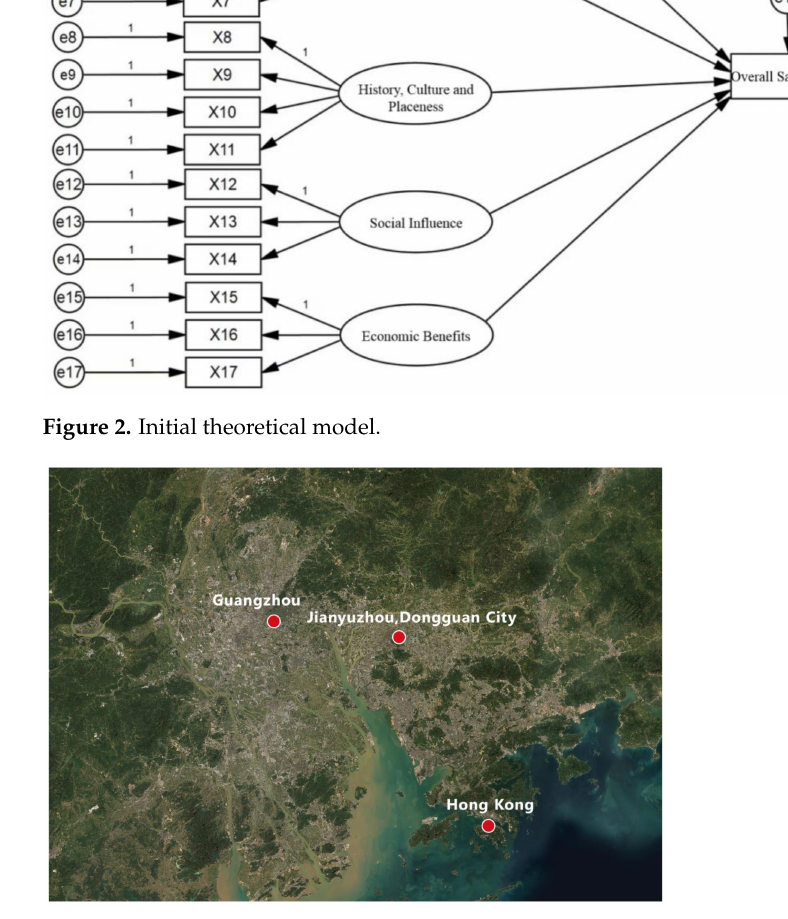
Figure 3. The location of the research subject.